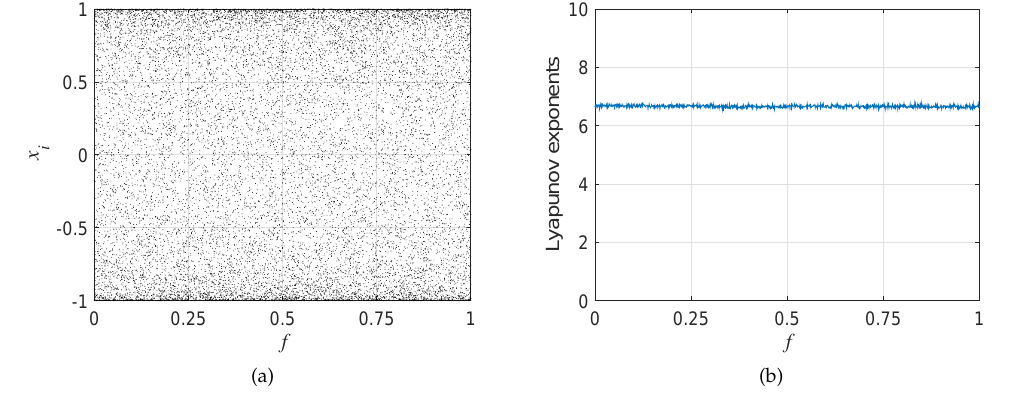
Figure 2. The ( a ) bifurcation diagram and ( b ) Lyapunov exponents of